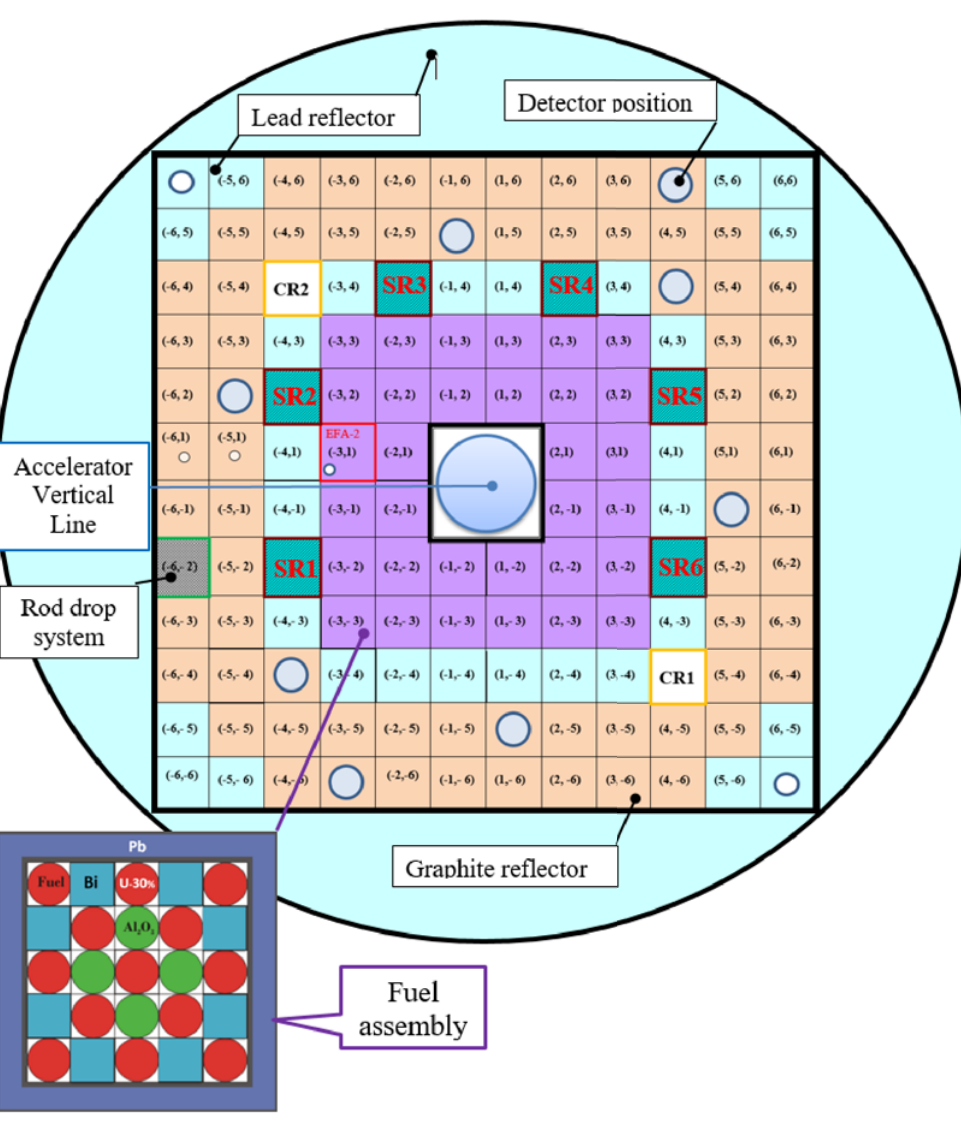
Figure 1. The SC10 sub-critical core